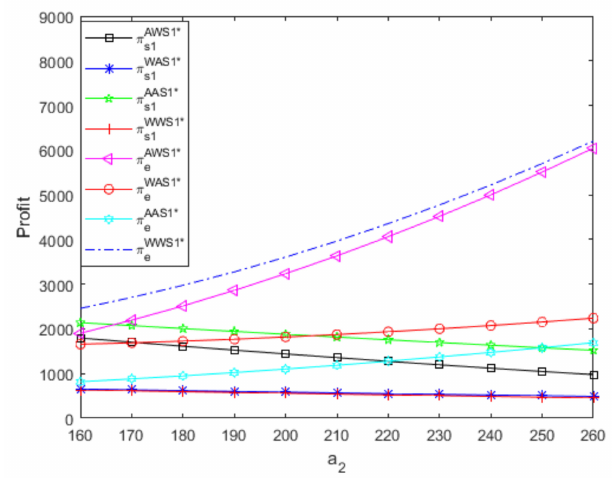
Figure 8. Changes of two suppliers’ profits with a 2 .